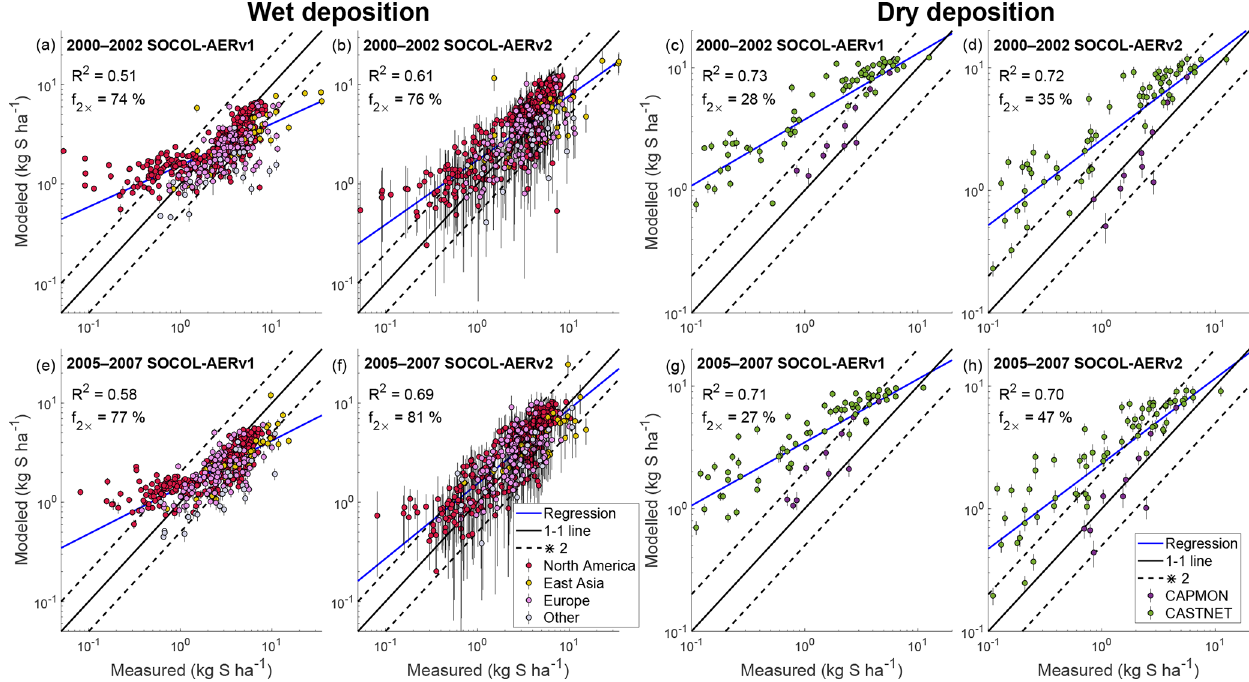
Figure 6. Evaluation of modeled total sulfur wet (a, b, e, f) and dry (c, d, g, h) deposition fluxes against measurement sites from the WMO database (Vet et al., 2014). SOCOL-AERv1 and SOCOL-AERv2 are compared with measurements averaged in two different time periods, 2000–2002 and 2005–2007. The ensemble standard deviation for the model results is shown as vertical bars. A power regression between the simulation results and measurements is shown in blue and can be compared to the one-to-one line shown in black. Two model evaluation metrics are listed on the plots: the goodness of fit of the power regression between model and measurements ( R 2 ) and the fraction of stations where the model is within a factor of 2 of measurements ( f 2 × ). Points are colored according to the region (for the wet deposition plots) or the measurement network (for the dry deposition plots) of the measurement